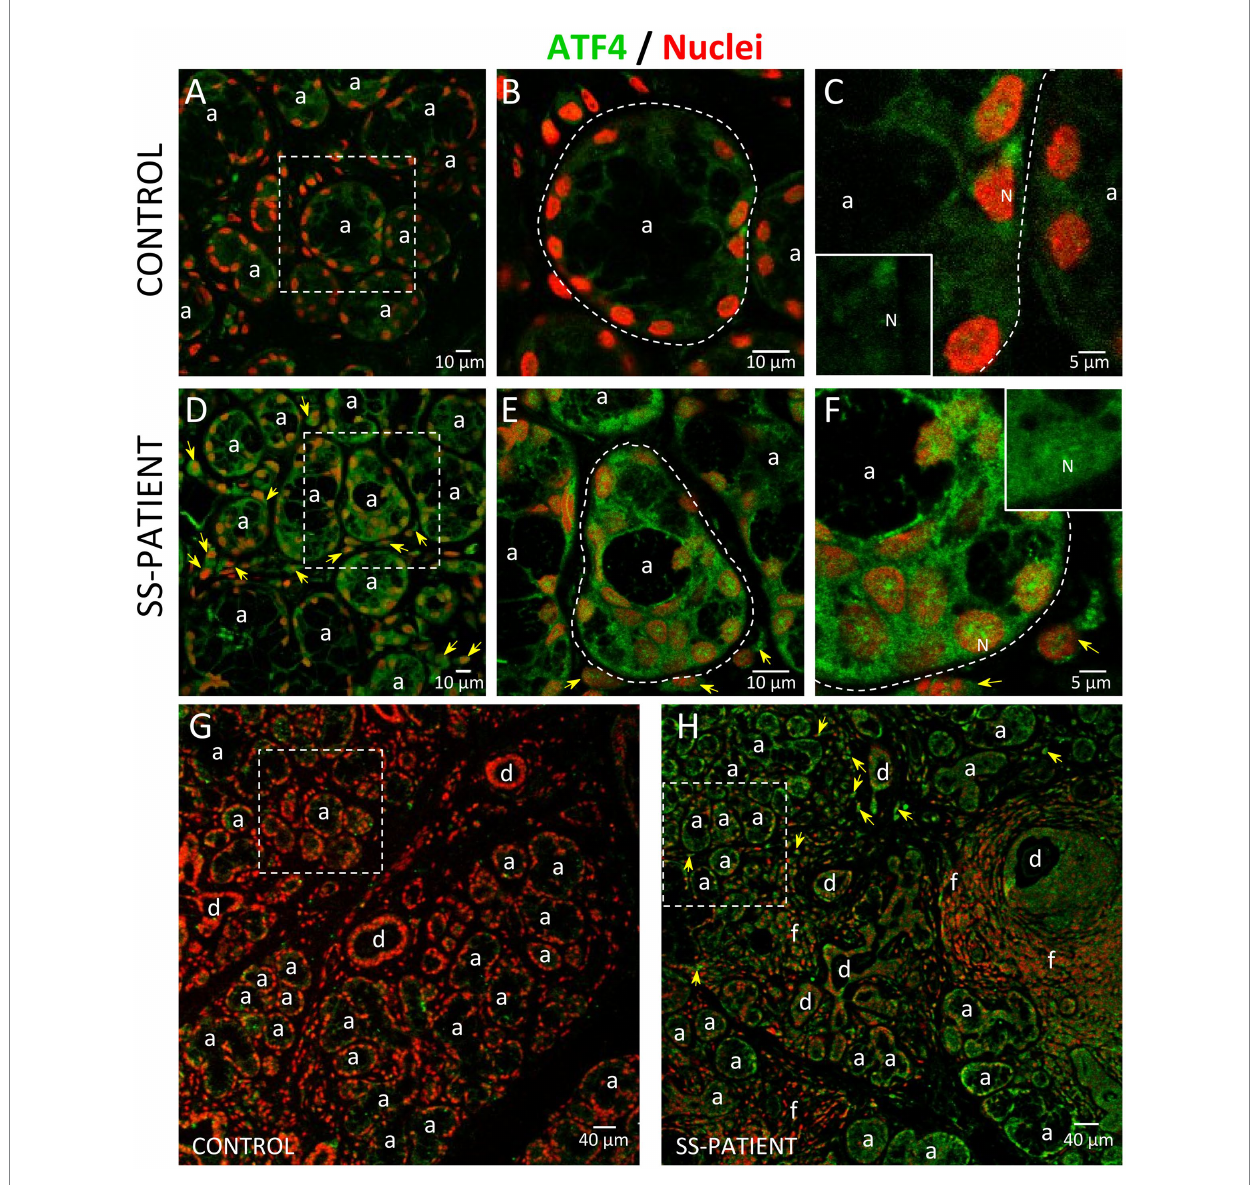
FIGURE 13 Localization of ATF4 in LSGs from control and SS-patients. (A–C,G) ATF4 (green) shows weak staining in the cytoplasm of epithelial cells in LSGs from control subjects. (D–F,H) Stronger ATF4 (green) staining was observed in the cytoplasm and nuclei (N) of epithelial cells in LSGs from SS-patients and in plasma cells (yellow arrows). (A,D) higher magnifications of regions surrounded by broken lines in G and H, respectively. (B,C,E,F) Higher magnifications of regions surrounded by broken lines in A and B, respectively. Nuclei (red) were counterstained with Hoechst-33342. a: acini; d: duct; f: focus of inflammatory cells. Bars A, B, D and E: 10 μ m; C and F: 5 μ m; G and H: 40 μ